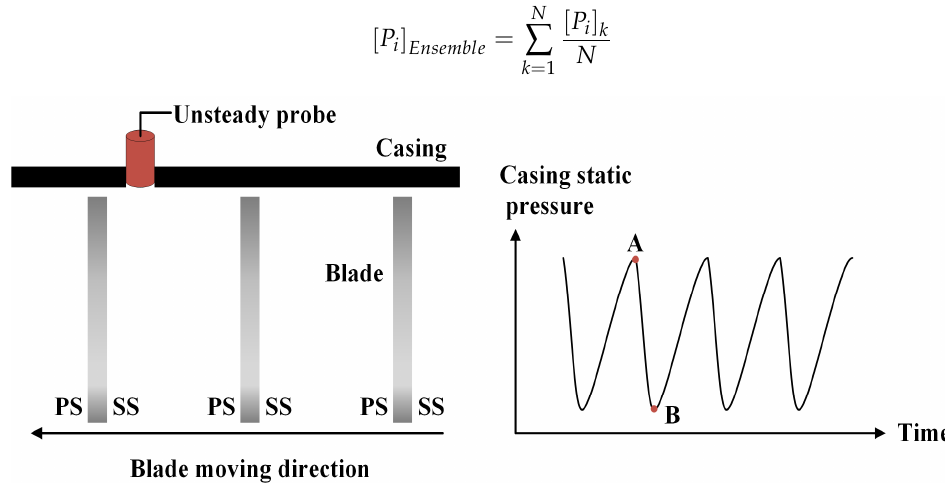
Figure 7. Schematic diagram of the blade passage signal.